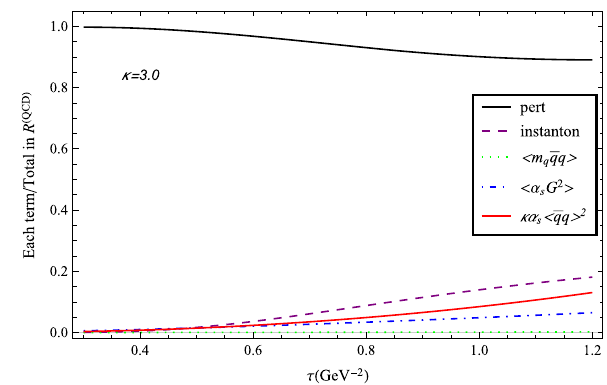
Fig. 3 The ratios of the various nonperturbative contributions with respect to the perturbative QCD part in R ( QCD ) . The two vertical dashed lines represent the conservative range of the parameter κ used in our study